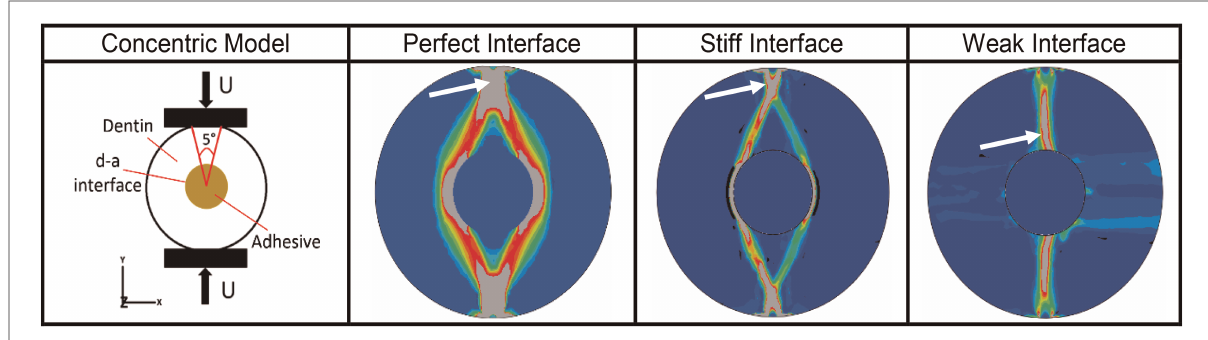
FIGURE 6 Results fromµmechanical stress-analysiaas ofd-ainterfacefor different type ofpotential interfacial conditions based upon fi nite element in-silicoanalyses of a concentric model of d-a interface formed by creating a hole in a cylindrical dentin sample. Panel 1 shows the schematic of the concentric model and its external loading regime. Panels 2 to 4 give the octahedral shear strain (blue-low, red-high) at post failure showing fracture zone (gray – indicated by white arrow) for three ideal cases of d-a interfacial conditions. For perfect and stiff interfaces, respectively, the fracture initiates from the load application zone on the sample periphery and propagates towards the interface, while for a weak interface, the fracture initiates from inside at the d-a interface and propagates outwards towards the loading